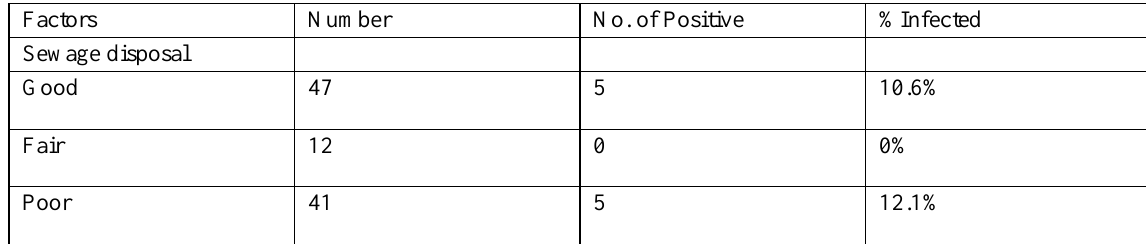
Table 1. The incidence rate in relation to adequate the sewage disposal system is in the home of the patient.